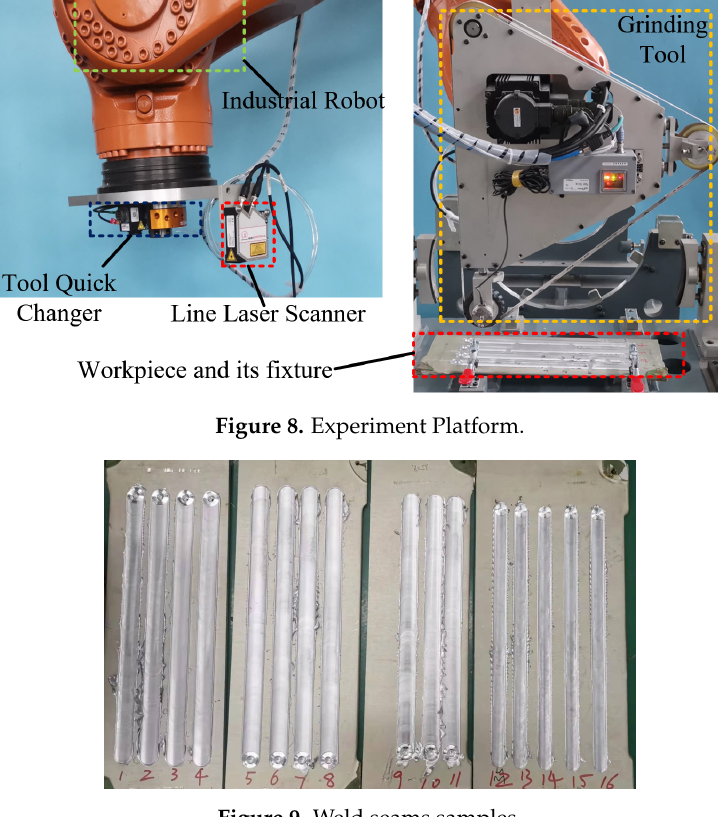
Figure 9. Weld seams